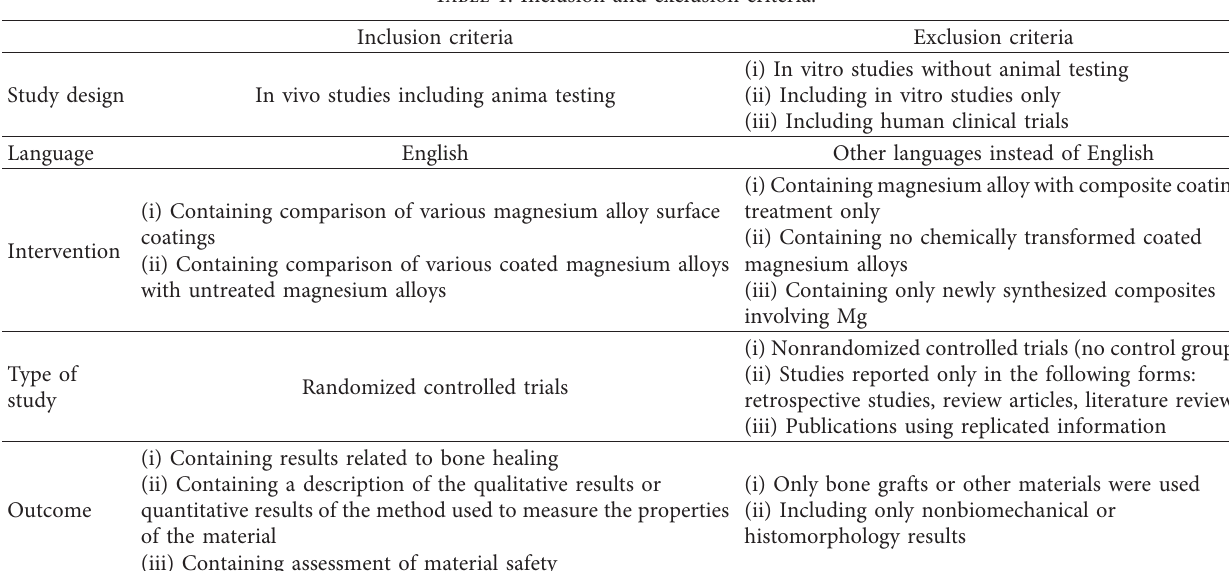
Figure 1: Outcome Table 1: Inclusion and exclusion criteria.